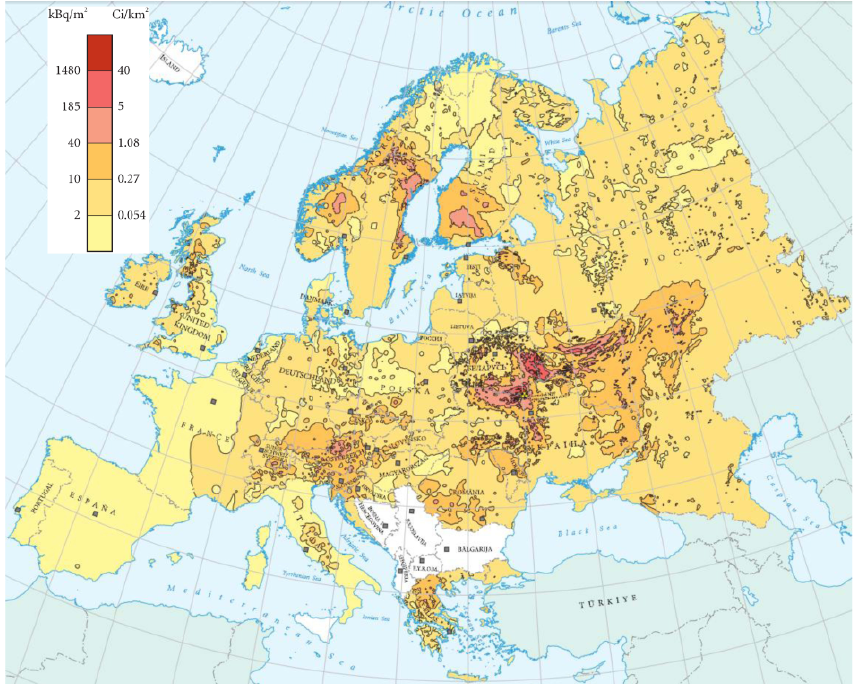
Fig. 11. The Atlas map depicting the total cumulative deposition of 137 Cs throughout Europe as a result of the Chernobyl accident from all available data of the REM database corrected for radioactive decay to 10 May 1986. The map has been published in the “Atlas of caesium deposition on Europe after the Chernobyl accident” (De Cort et al., 1998).